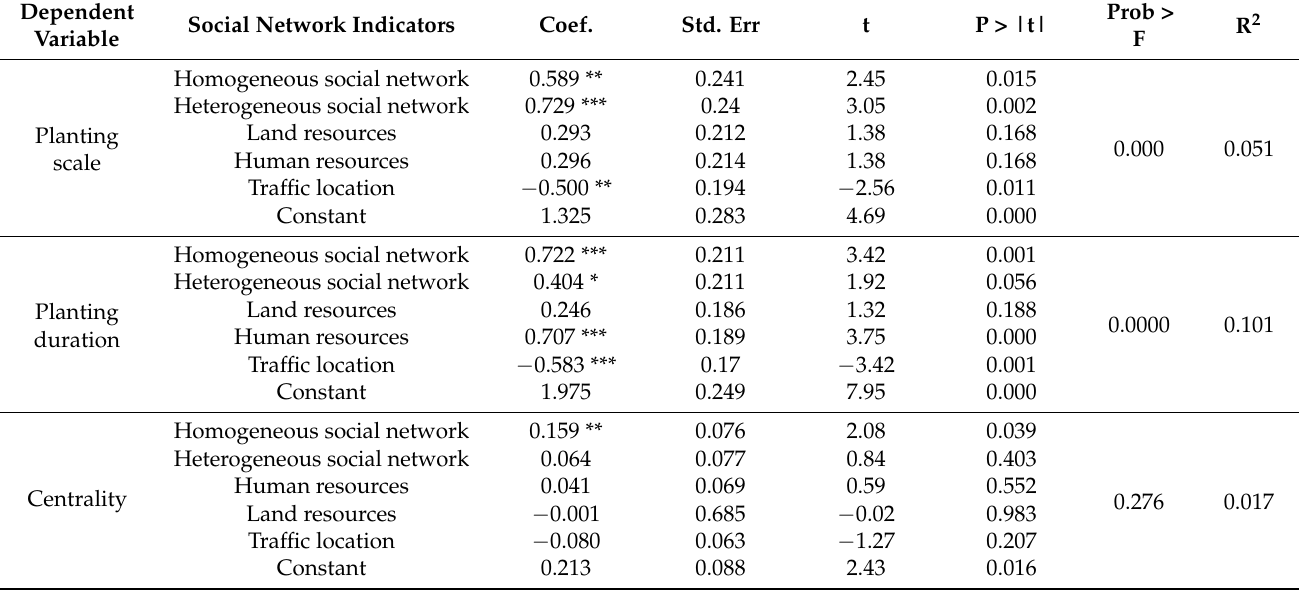
Table 3. Impact of social network on grape planting status in